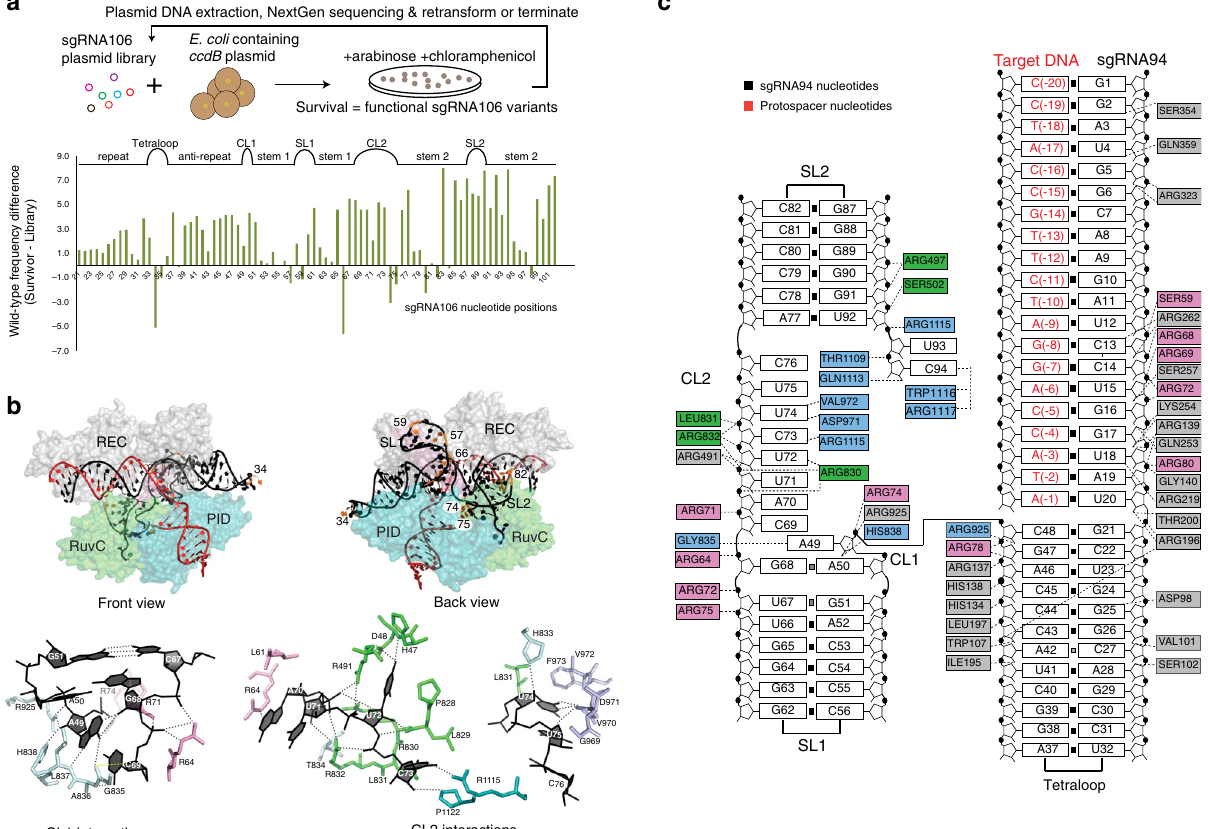
Fig. 3 Recognition of sgRNA by AceCas9. a Top: Schematic of the functional RNA selection procedure for identifying nucleotides critical to sgRNA function. Plasmids encoding both AceCas9 and a library of sgRNA106 were transformed into E. coli hosting a target plasmid that expresses the toxin ccdB. Functional variants of sgRNA were identi fi ed by sequencing the sgRNA library of the survival colonies. Bottom: Plot of the wild-type nucleotide read frequency difference between that of the survivor and that of the input libraries against the nucleotide positions. A low difference frequency indicates a high mutability and vice versa. Secondary structure elements are shown on top and denoted in same terms as in Fig. 2. b Top: Selected positions of highly varied nucleotides (orange) on the 3D structure in both front and back views. Bottom: Detailed protein – RNA interactions between connecting loops, CL1 or CL2, and AceCas9. RNA nucleotides are colored in black. Protein residues that within 3.6 Å from the displayed RNA nucleotides are displayed as sticks and are colored as in Fig. 2. Dashed lines denote polar interactions that are within 3.4 Å. c Detailed close-contact interactions between sgRNA and AceCas9 – Δ HNH. Amino acids are colored according to the colors used for the domains in Fig.